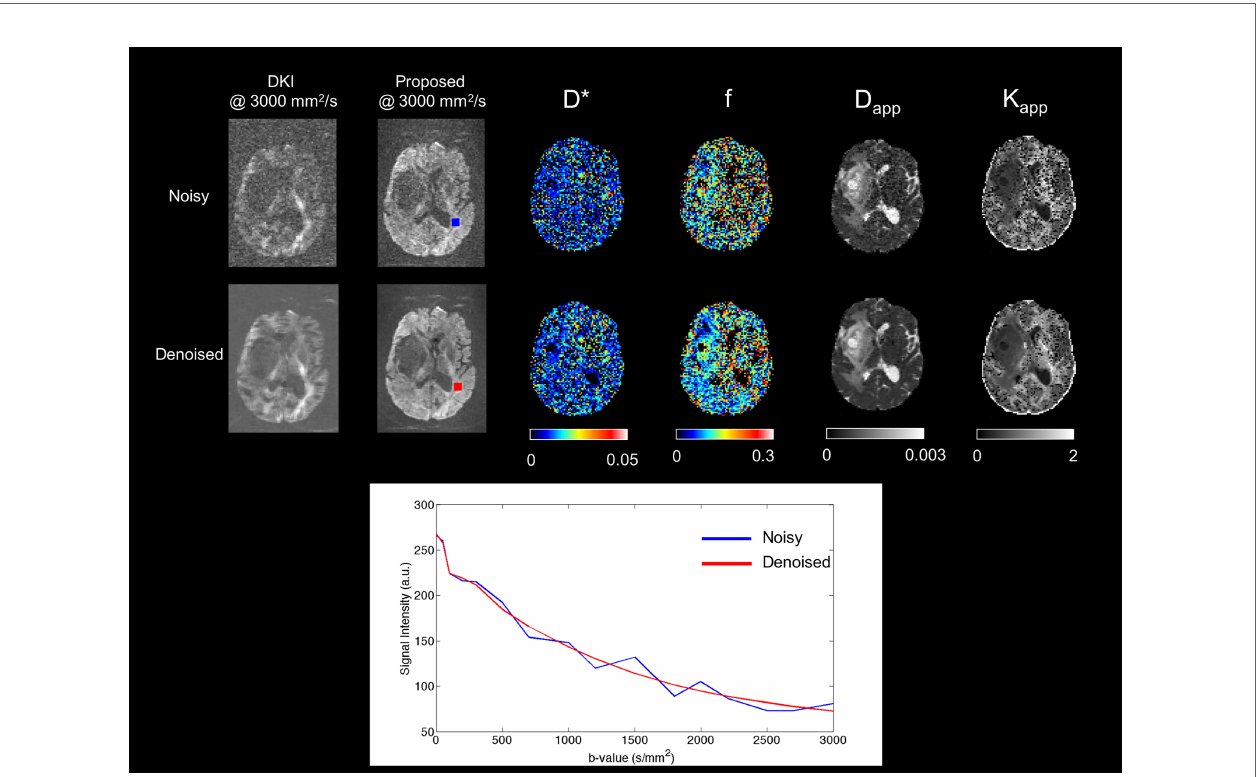
FIGURE 3 | Effect of the denoising algorithm on the images and signal. The images of the top row are from the DKI acquisition while those of the bottom row are from the proposed protocol. All images are shown without the application of a gaussian fi lter. The plot under the images shows the signal decay of a white matter voxel before (blue) and after (red) denoising. The in fl uences of the denoising are more apparent as the b-value